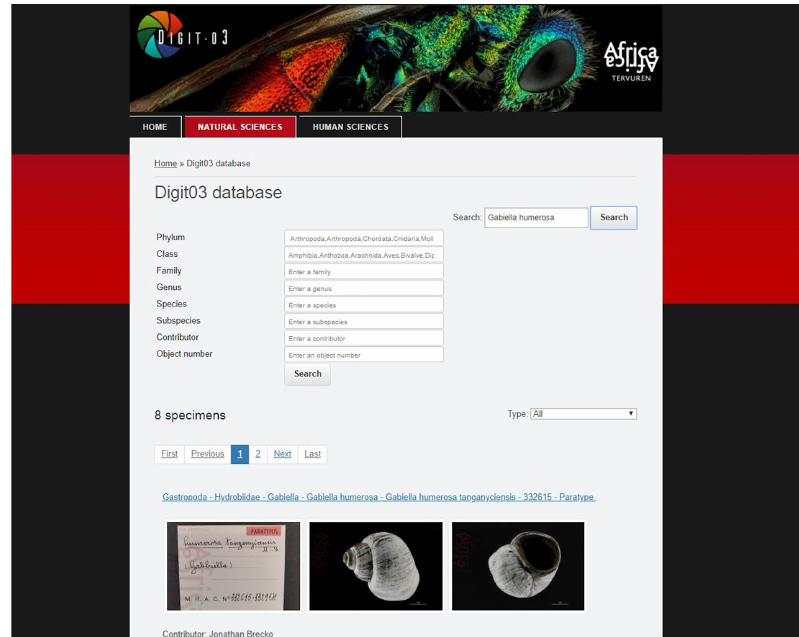
Fig. 8.5. RMCA Digit03 dissemination